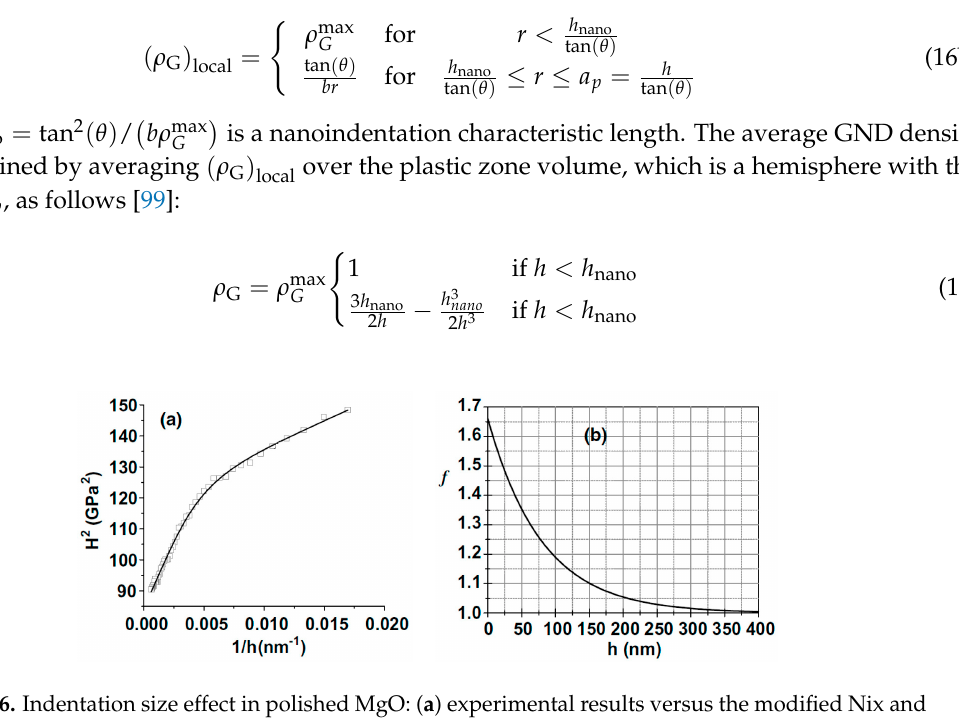
Figure 7. Comparison between the indentation size effect captured using the strain gradient plasticity